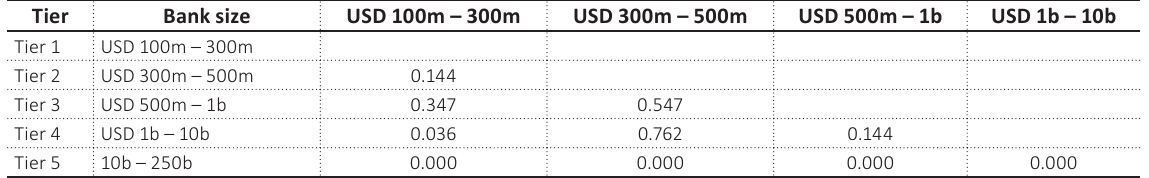
Table 5. P-value of quarterly portfolio maturity proxy by bank size